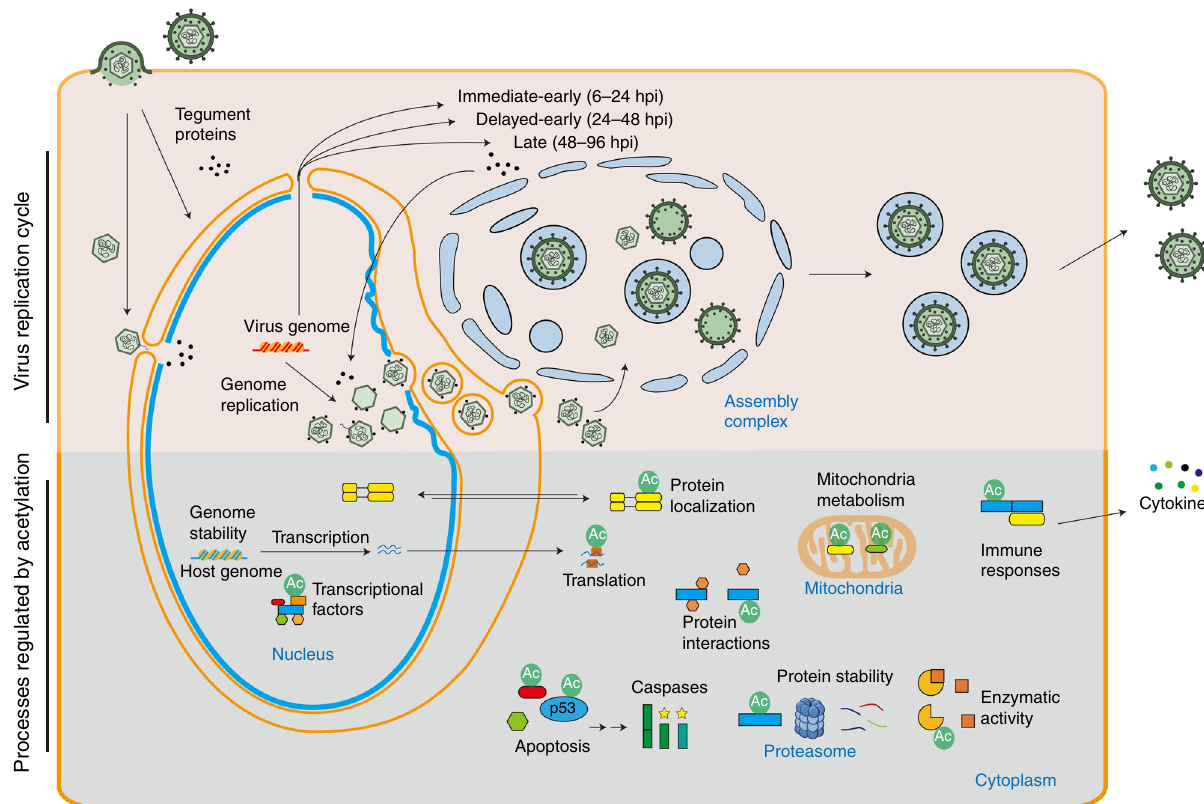
Fig. 1 Acetylation contributes to diverse protein functions in uninfected and infected cells. Host pathways that are regulated by acetylation in uninfected cells are manipulated by HCMV during its temporal replication